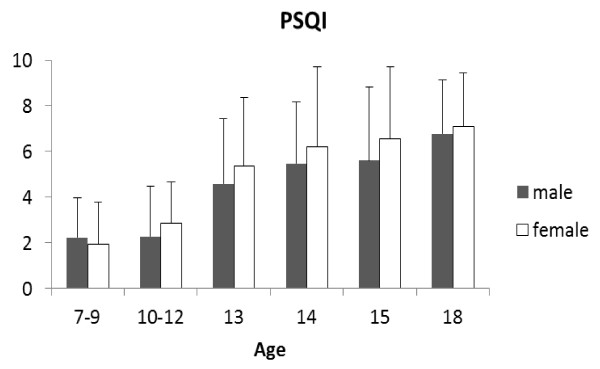
Pittsburgh Sleep Quality Index scores in male and female school children of different ages. Filled bars, boys; open bars, girls. Scores > 5 indicate some problems with sleep.